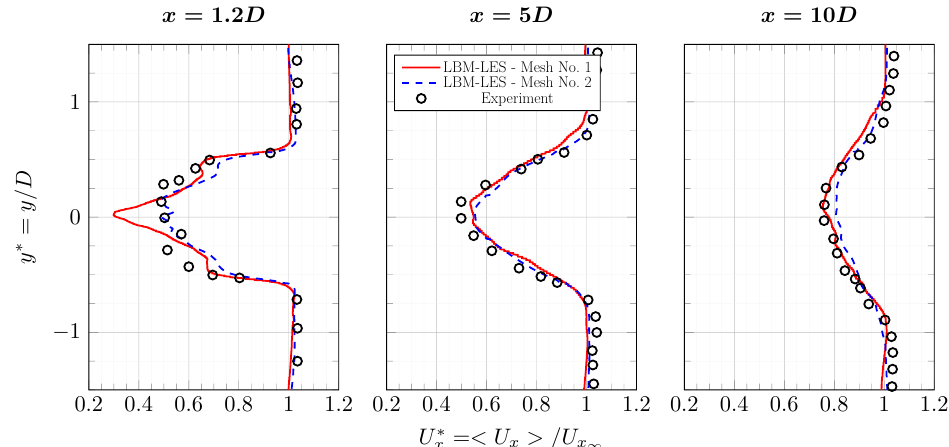
Figure 16. Average axial velocity profiles in the wake of the tidal turbine at TSR = 3.67 and I = 3%. Results are from experiment [6] and from LBM-LES simulations with mesh Nos. 1 and 2. The complete set of profiles is in Appendix A.